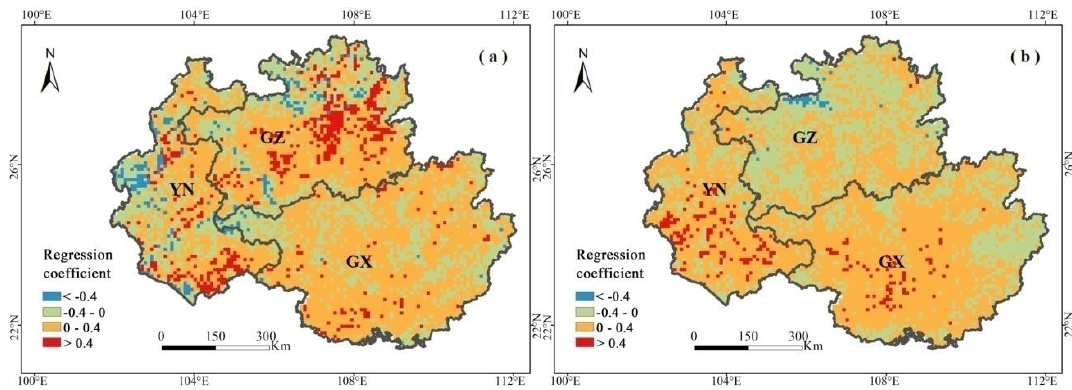
Figure 7. Multivariate regression coefficients of temperature ( a ); and precipitation ( b ) to NDVI based on pixel during